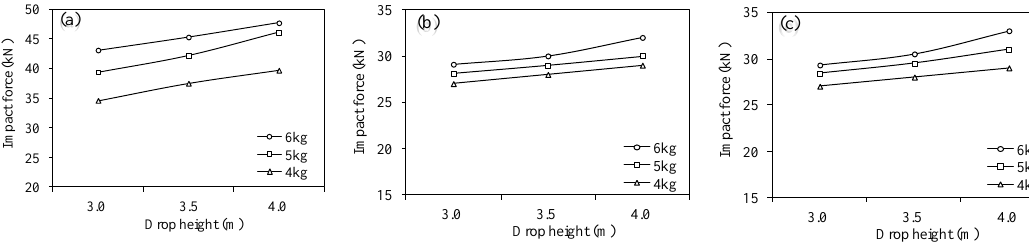
Figure 6. Impact force vs. drop height for samples of different shapes: (a) spherical, (b) cubic, and (c) cylindrical.